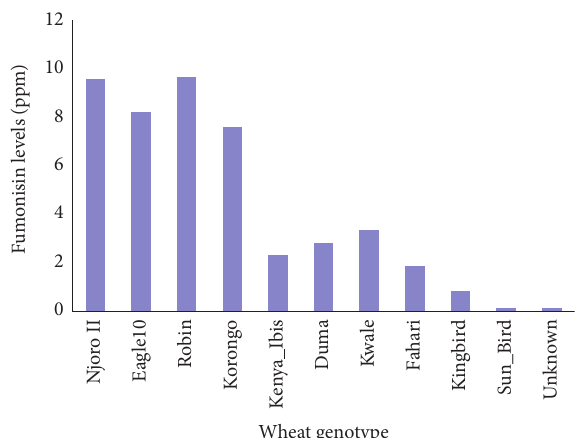
Figure 5: A comparison of fumonisin levels in the grains of wheat genotypes at harvest in three major wheat producing Counties in Kenya.